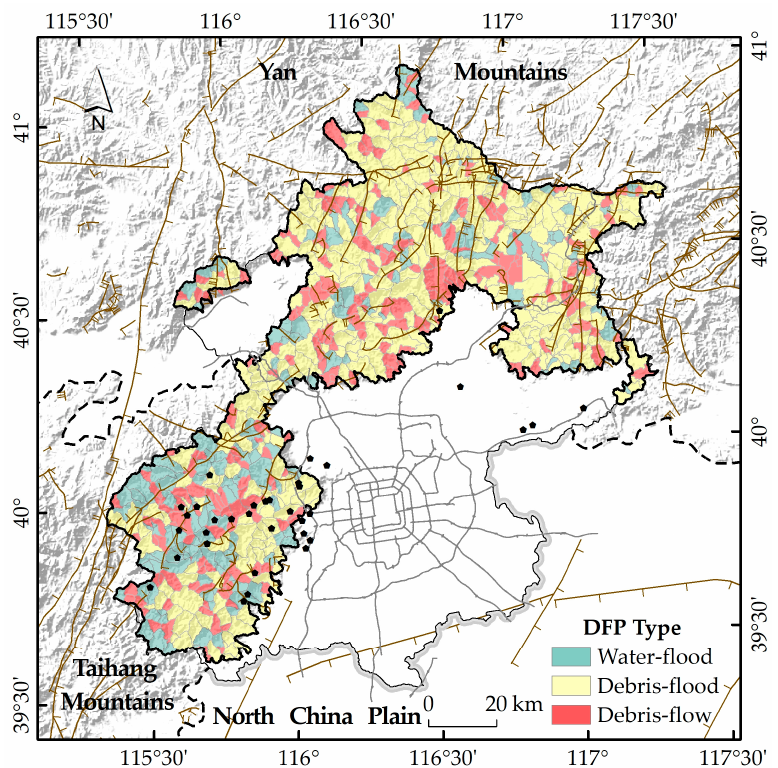
Figure 8. Distribution of the DFP types based on the RF model. The black points are coal mines and the brown lines are the main faults in Beijing mountainous area.